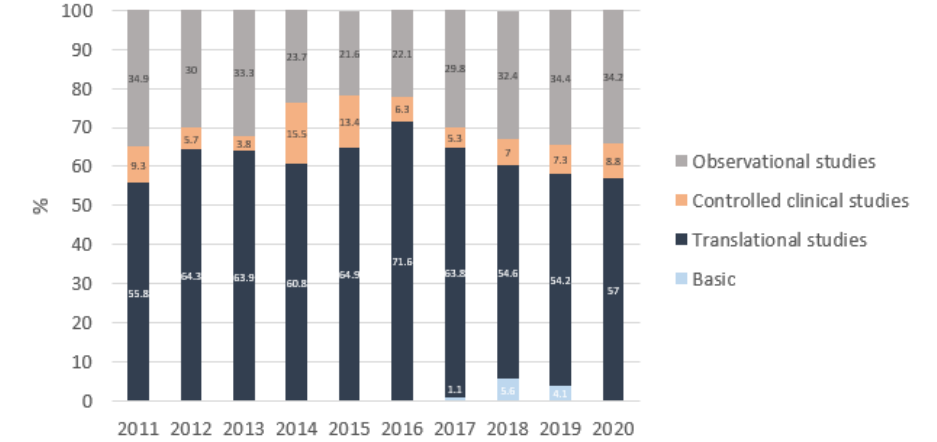
Figure 6. Evolution of the different types of articles during the 10 year period.